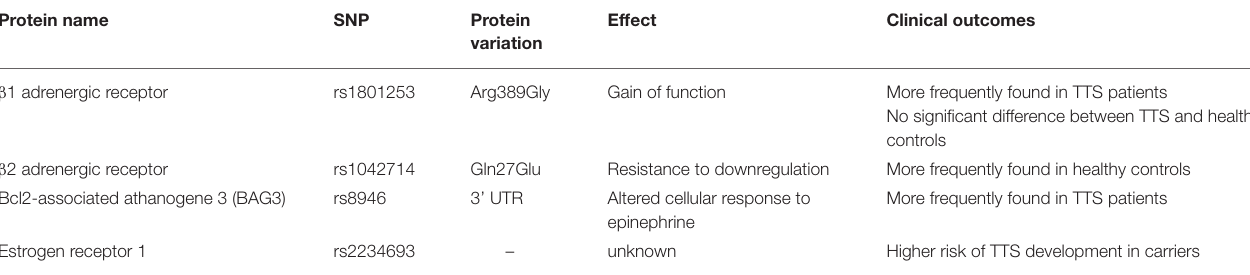
TABLE 3 | Table summarizing studies on TTS genetic markers. Protein